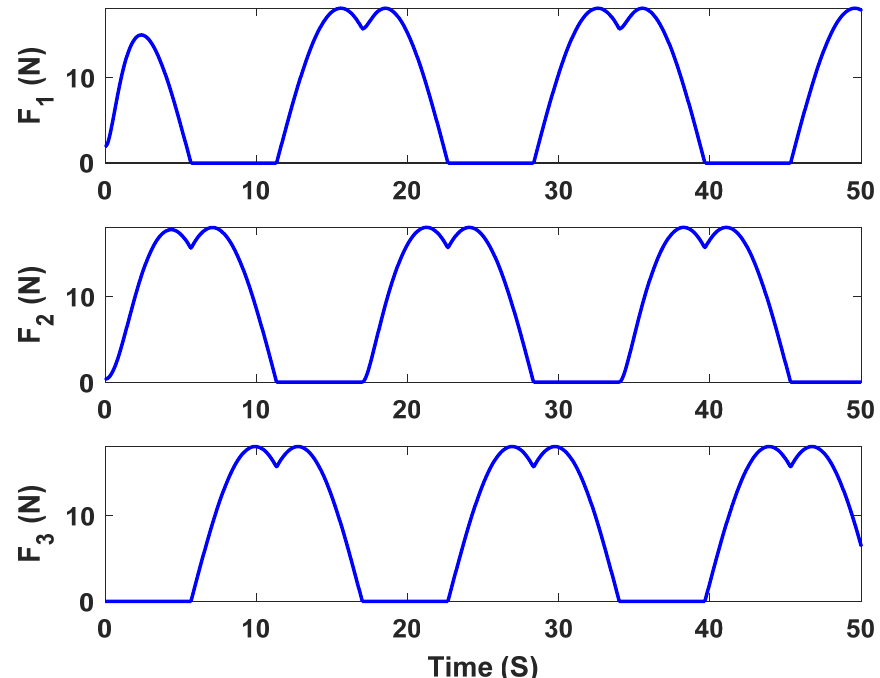
Figure 12. CR tensions in the second control